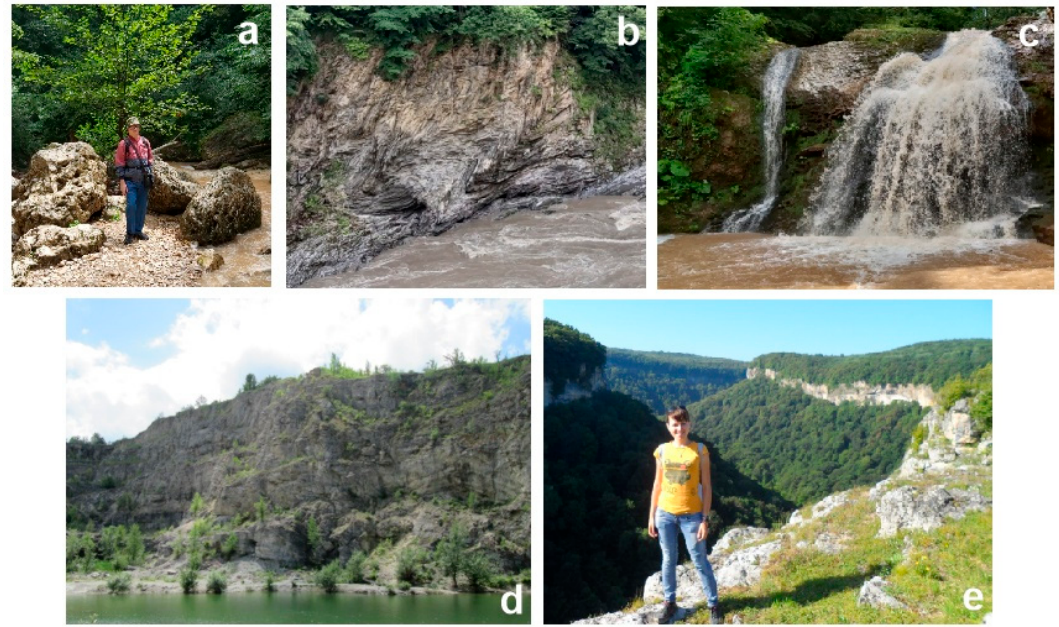
Figure 4. Geoheritage of the study area (part 2): a —megaclasts of the Rufabgo Canyon (D.A.R. stays for scale), b —chevron folds in the Triassic deposits, c —the Shum waterfall, d —the Khadzhokh quarry and the Krasnoe artificial lake, e —panoramic view of the Mishoko Canyon demonstrating the aesthetic potential of this point to (geo)tourists (A.V.M. stays for scale).